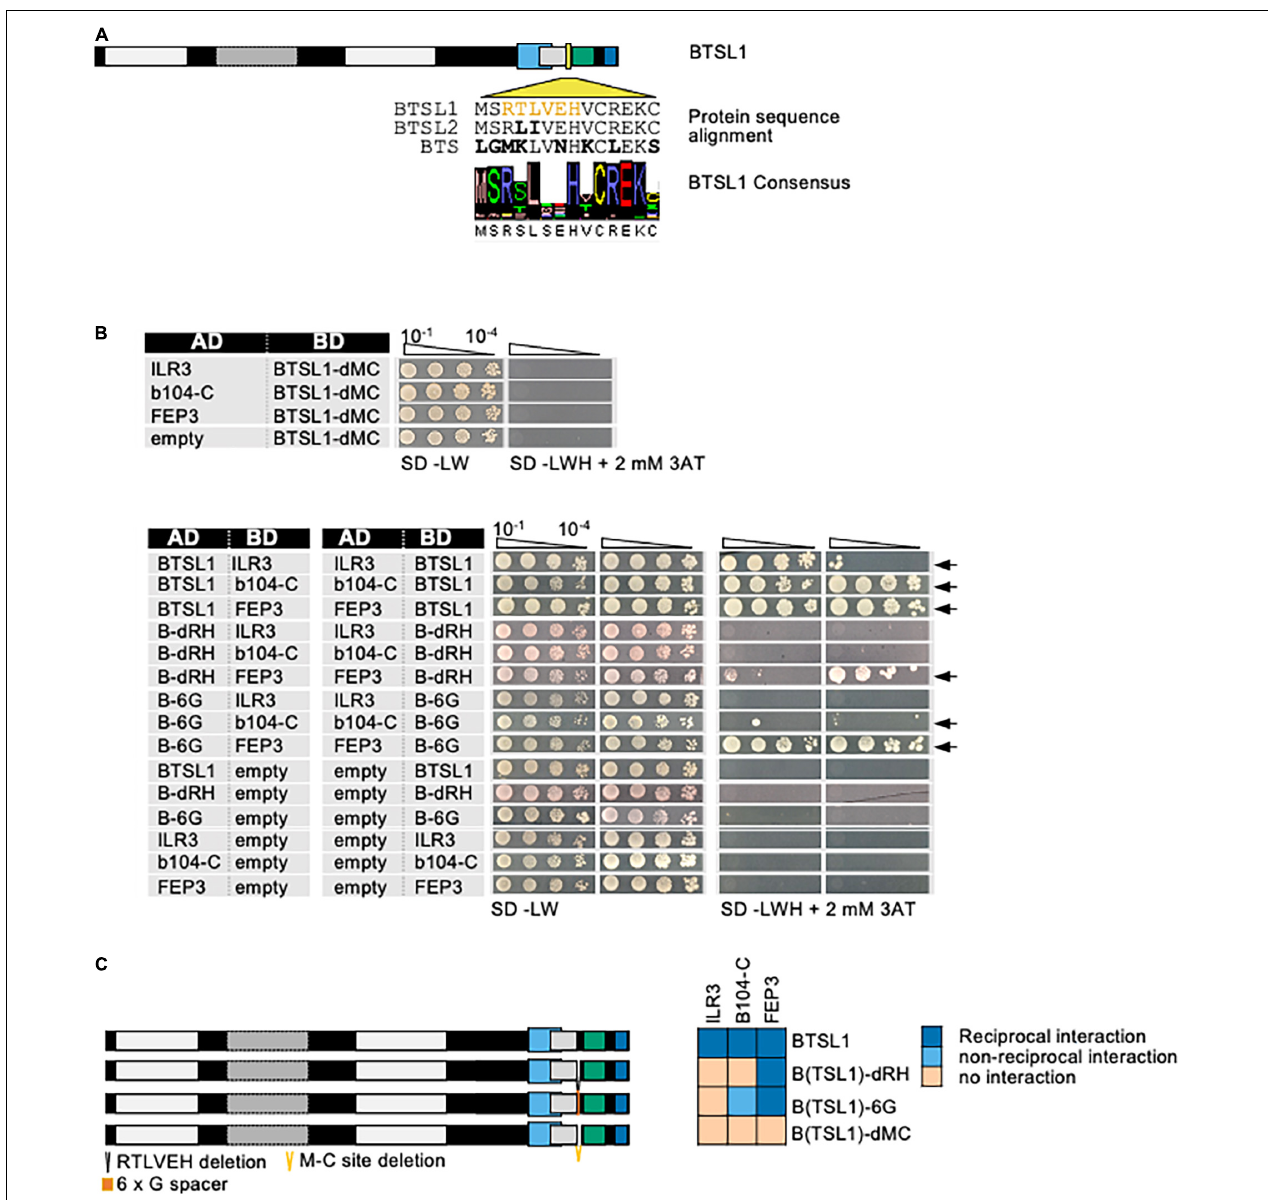
FIGURE 4 | Fine-mapping of the interaction sites in BTSL1 by yeast two hybrid (Y2H) assays. (A) Protein structure of BTSL1 and protein sequence alignment of the interaction M-C site within the yellow-boxed region that is highlighted, see also Figure 3B . A further sub-region is marked in orange letters, R-H site. The consensus sequence was obtained by identifying orthologs using blastp and comparing the sequences of the 100 best hits. (B) Small targeted deletion forms of BTSL1-C of or within the M-C site were tested in reciprocal targeted Y2H assays against ILR3, bHLH104-C (b104-C) and FEP3/IMA1. Yeast co-transformed with the AD and BD combinations were spotted in 10-fold dilution series (A 600 = 10 − 1 –10 − 4 ) on SD-LW (transformation control) and SD-LWH plates supplemented with 3AT as indicated (selection for protein interaction). Negative controls: empty vectors. Arrows indicate interaction. (C) Schematic representation and summary of Y2H results. Left, schematic representation of full-length BTSL1 and deletion constructs of and within the M-C site, used for Y2H. B-6G is a sextuple glycine spacer. The regions are indicated in color. Right, summary results of panel (B) . The color code distinguishes reciprocal positive interactions (dark blue), non-reciprocal positive interactions (light blue), negative results on interactions (light orange).